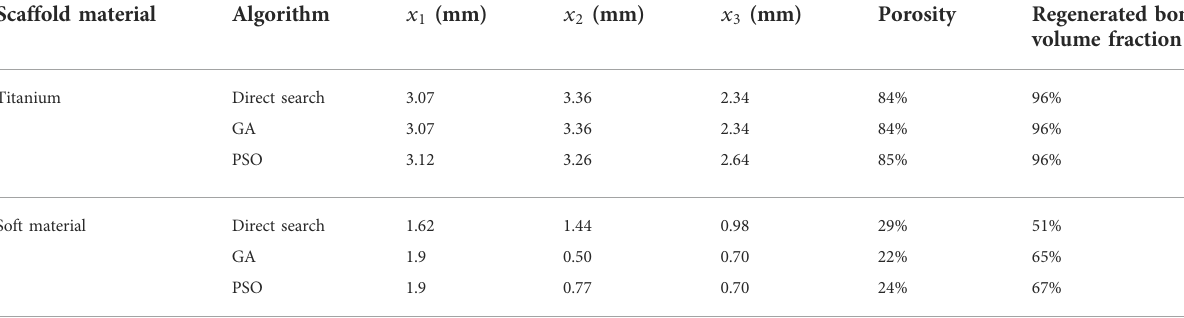
TABLE 2 Optimization results for both scaffold compositions using various algorithms. Scaffold